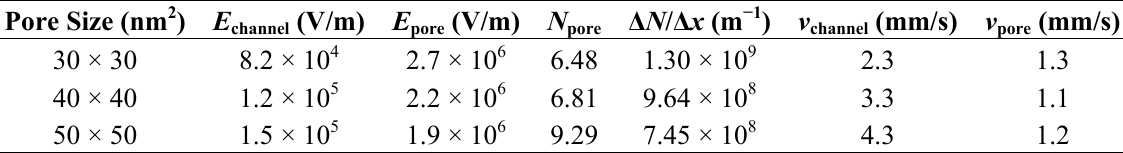
Table 2. Electric field and ssDNA transpore properties in the nanochannel and nanopore. Pore Size (nm 2